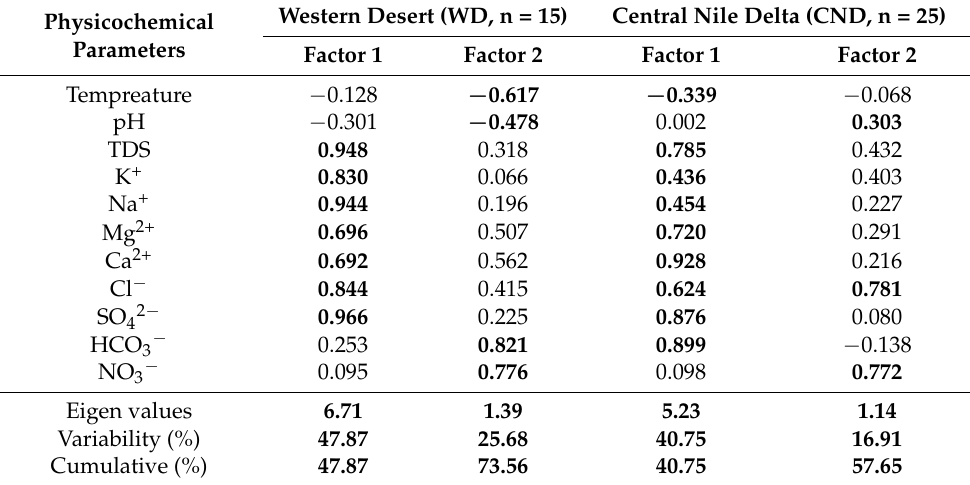
Table 2. Factor loading after varimax rotation, eigen values, variability (%), and cumulative (%) of different physicochemical parameters for groundwater samples collected from the Western Desert and Central Nile Delta. The values of all parameters are expressed in mg l − 1 except for temperature ( ◦ C) and